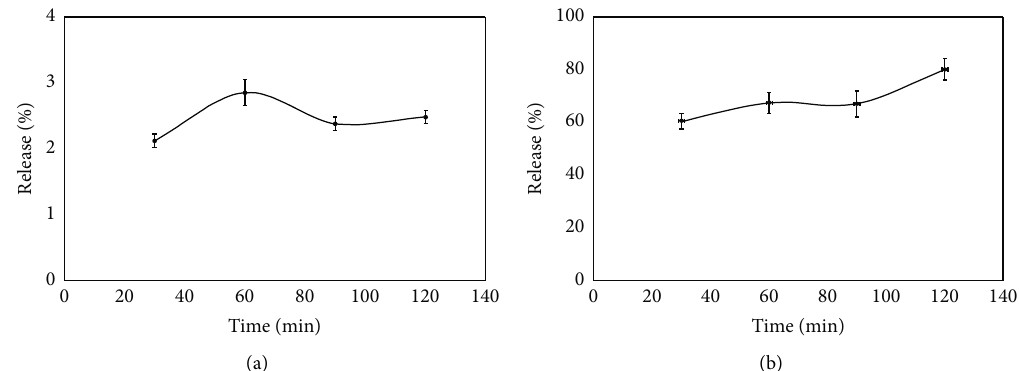
Figure 6: Graphs of bioactive compounds released from microcapsules of R . tuberosa (L.) extract prepared in pH 4, 90min stirring time, and 0.1% chitosan: (a) pH 2.2 and (b) pH